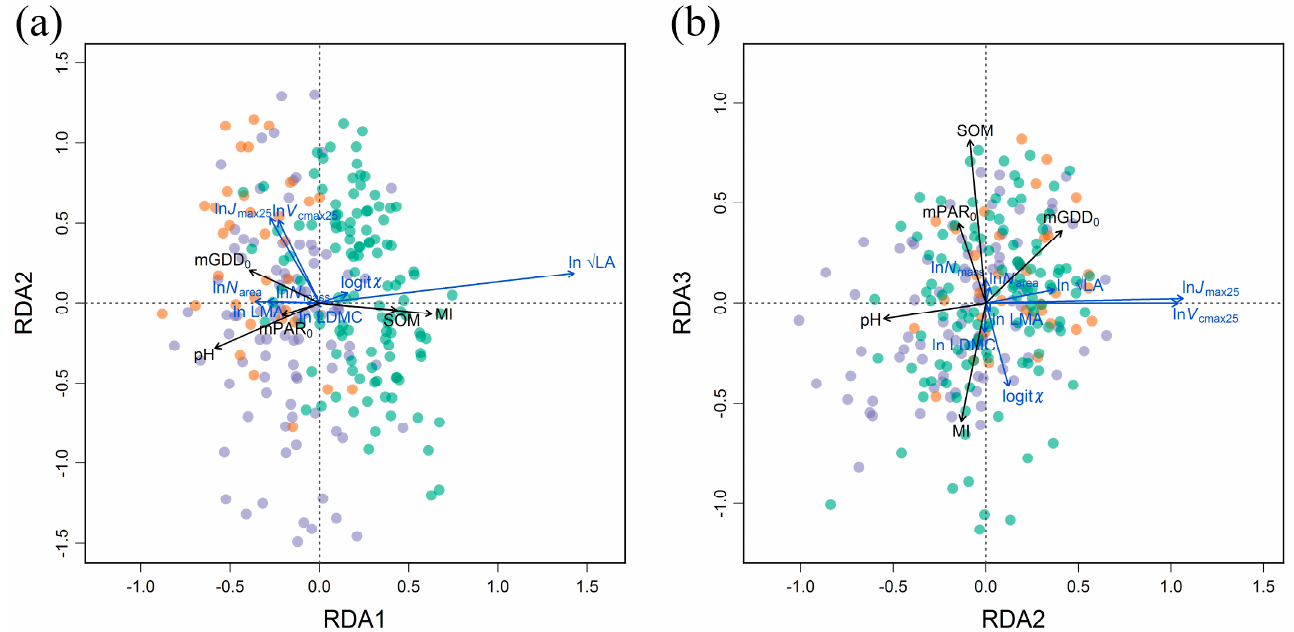
Figure 6. Redundancy analysis (RDA) for eight traits and climate/soil variables. ( a ) RDA1 versus RDA2. ( b ) RDA2 versus RDA3. LA: leaf area; N mass : leaf nitrogen content per mass; N area : leaf nitrogen per area; LMA: leaf mass per area; LDMC: leaf dry mass content; V cmax25 : maximum carboxylation rate standardized to 25 °C; J max25 : maximum electron transport rate standardized to 25 °C; χ : ratio of intercellular to ambient CO 2 concentration. MI: moisture index; mGDD0; monthly growth temperature above 0 °C; mPAR0: monthly photosynthetically active radiation above 0 °C; pH: soil pH; SOM: soil organic matter content.